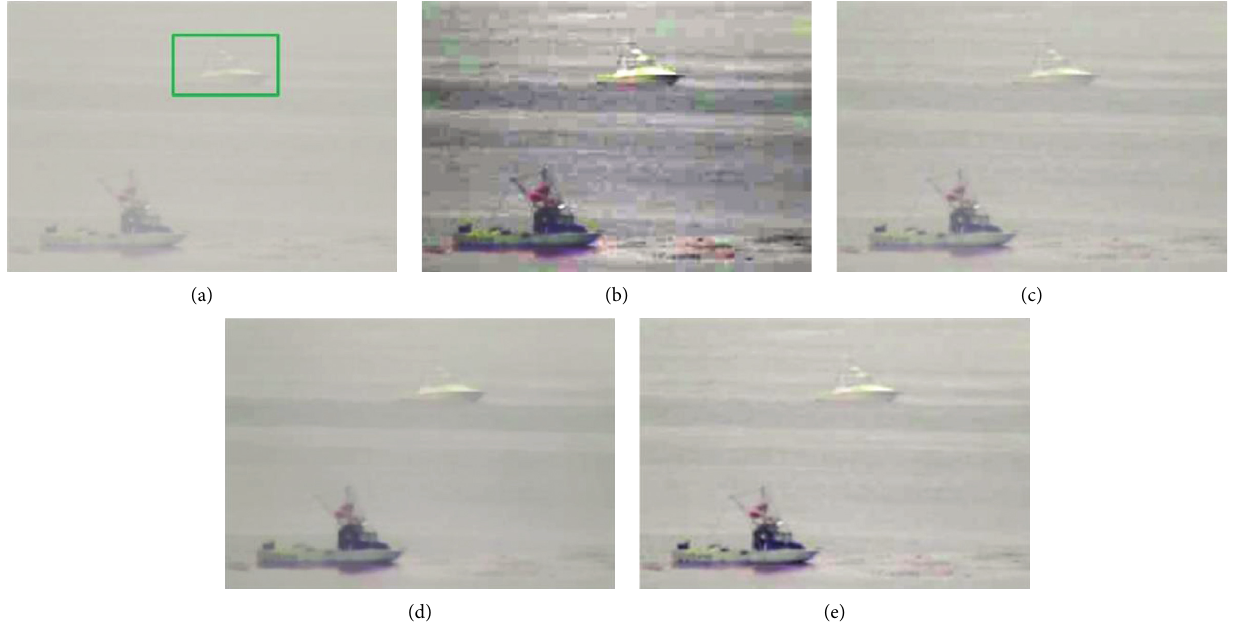
Figure 10: Visual comparisons of realistic dehazing experiments. The proposed method is able to significantly improve the image quality and preserve important structures. (a) Haze, (b) DCP, (c) RIVD, (d) MSCNN, (e)